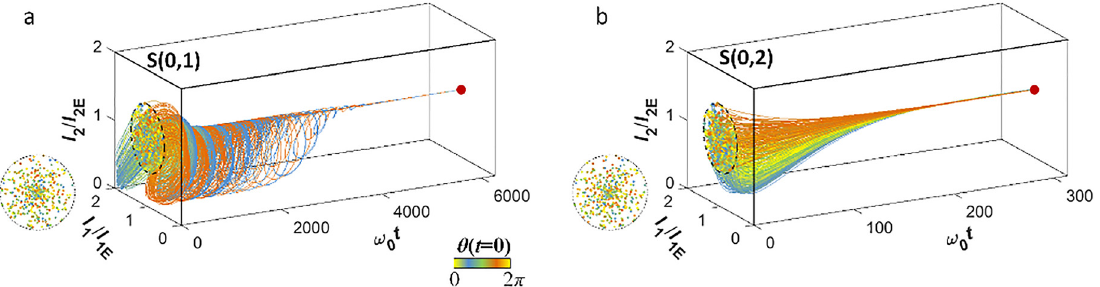
Figure 2: Topologically protected phase portraits.